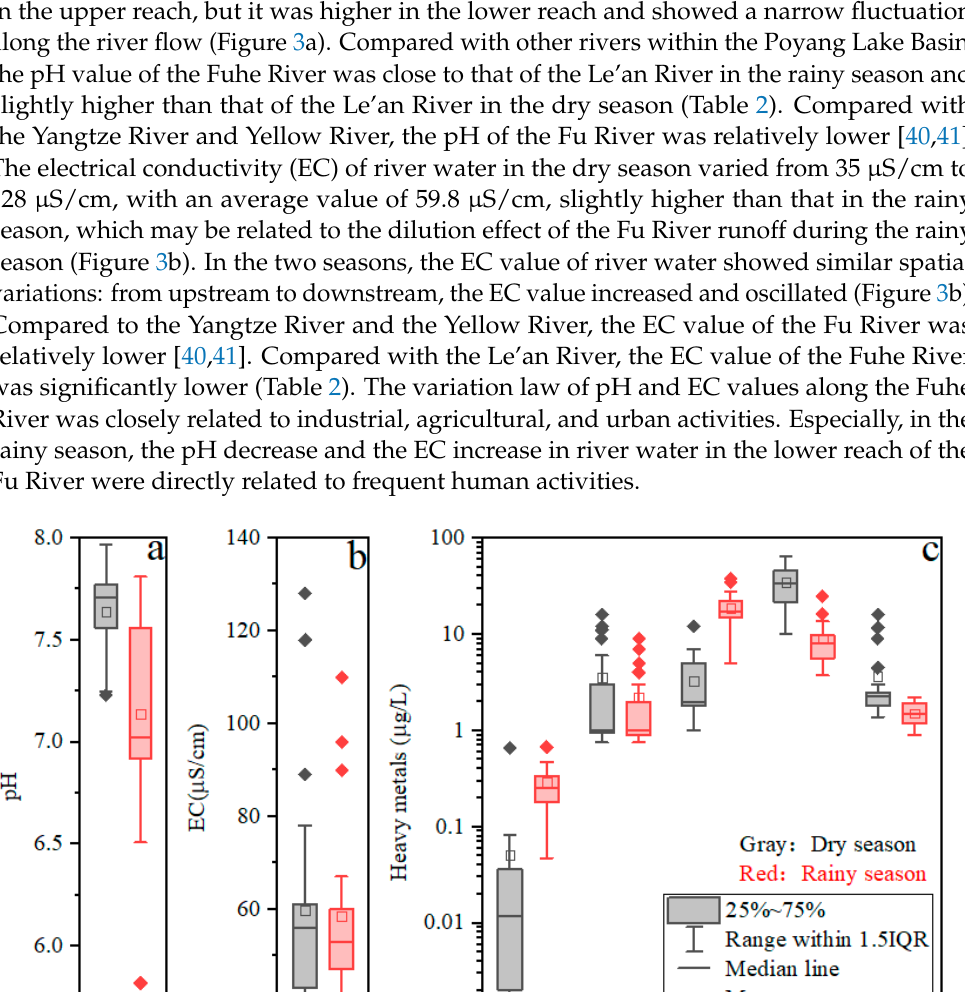
Figure 3. Spatial variations of ( a ) pH, ( b ) EC values, and ( c – g ) heavy metal concentrations along river flow.